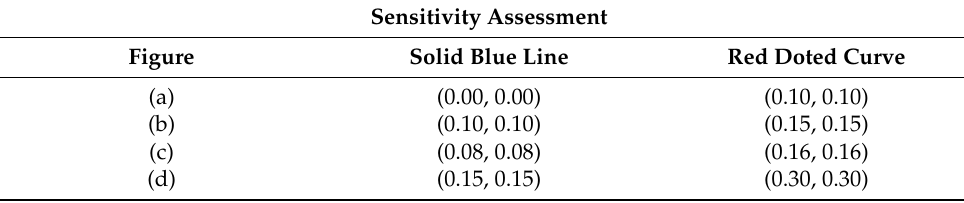
Table 1. Sensitivity Study. Sensitivity Assessment Figure Solid Blue Line Red Doted